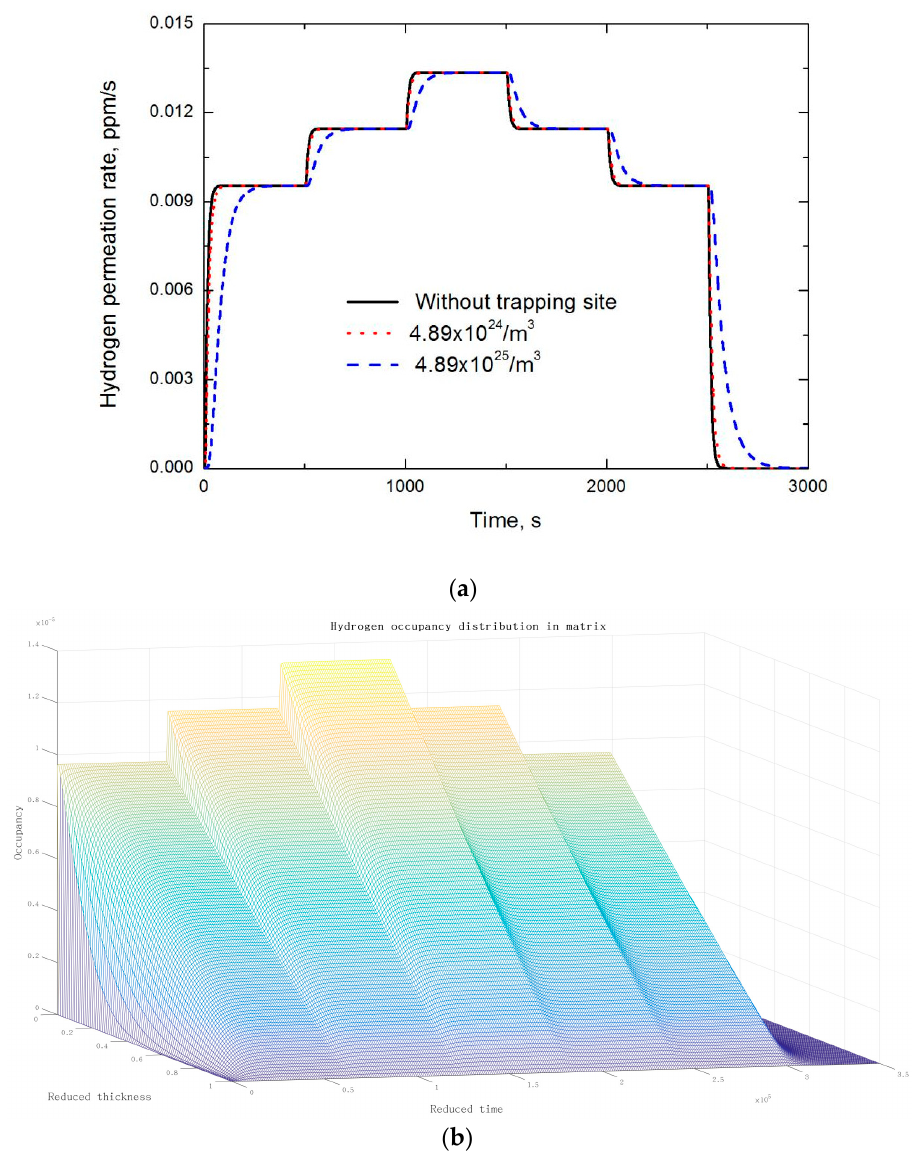
Figure 4. Simulated partial permeation transients varying trapping sites density and charging hydrogen concentration. ( a ) simulated permeation curves and ( b ) hydrogen occupancy distribution across the simulated specimen.